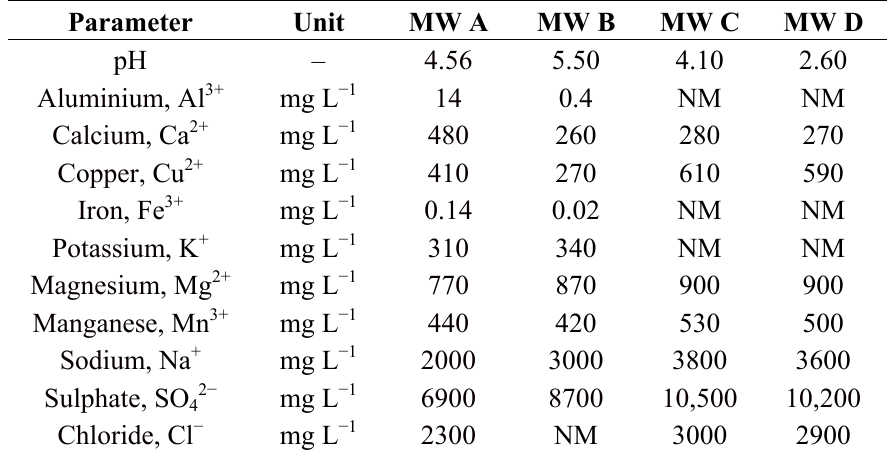
Table 2. Composition of mine water (MW) samples. MW A: provided by a copper mine in Western Australia. MW B and MW C: samples recreated based on the analytical composition of MW A. MW D: sample prepared from MW C by titrating the pH down from 4.10 to 2.60. NM: parameter not measured.